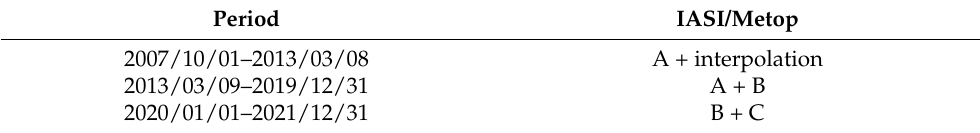
Table 1. IASI/Metop used according to the period.